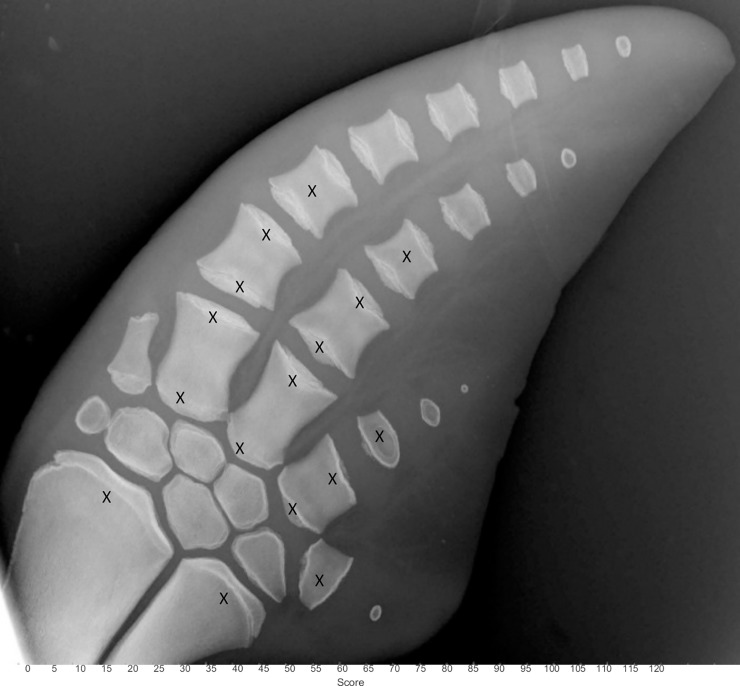
Scoring locations to systematically age a pectoral radiograph in the bottlenose dolphin.Anatomic locations included in the assessment are denoted by X and include the distal surfaces of the radius and ulna, the proximal and distal metacarpals II, II and IV, metacarpal V and the proximal and distal surfaces of the first phalange associated with metacarpals II and III. In addition the second phalange for metacarpals II and III and the first phalange associated with metacarpal IV were given a combined score for the proximal and distal surfaces.